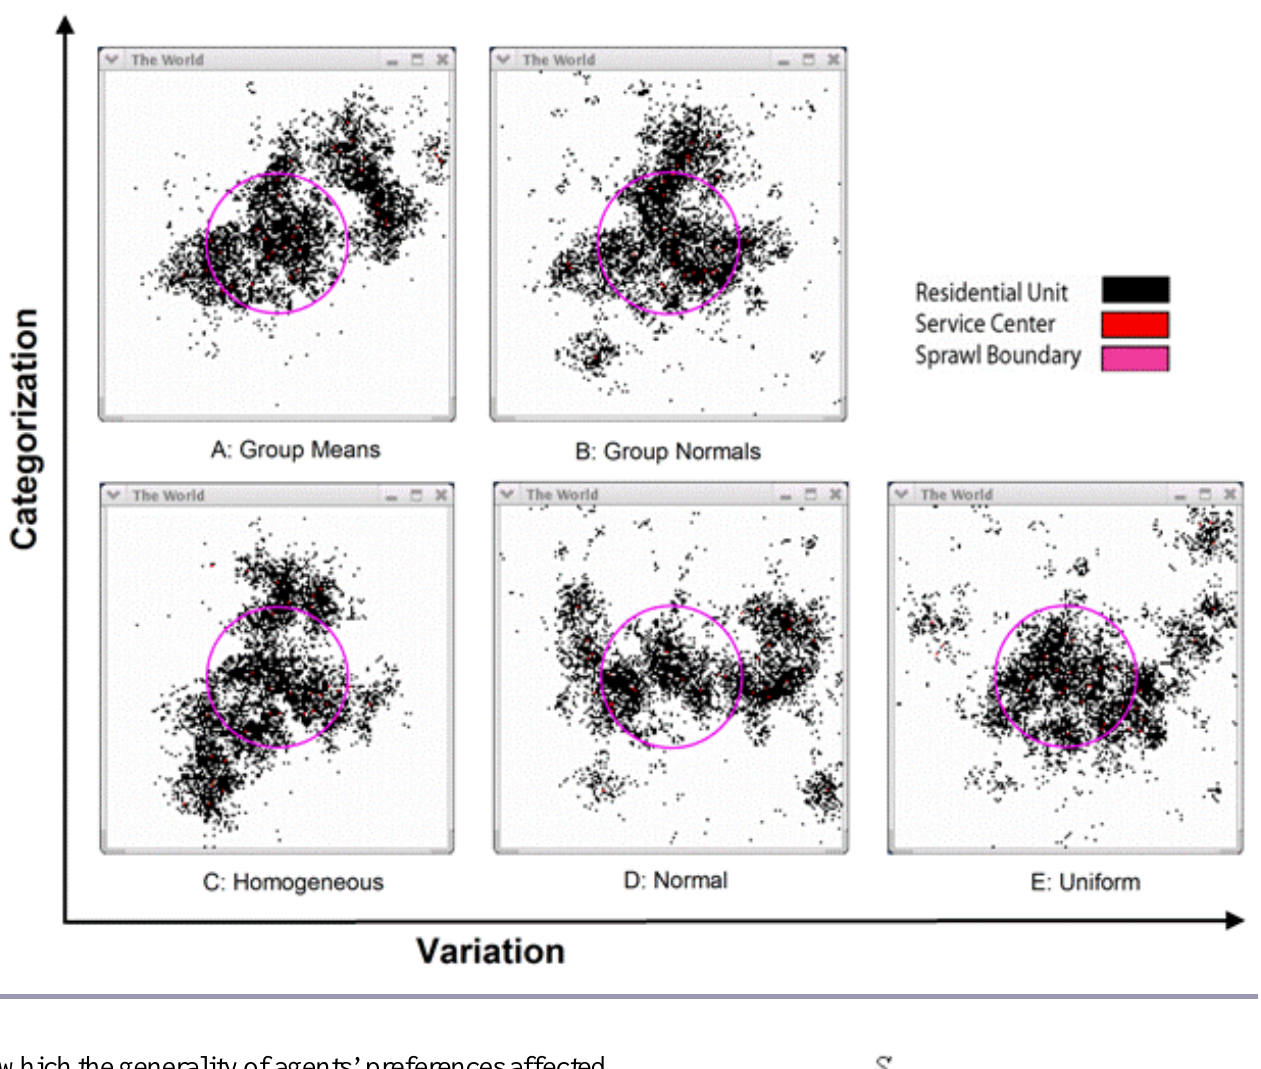
Fig. 4. Representative map results from a single run of the model under each of the experimental settings: A) Group Means, B) Group Normals, C) Homogenous, D) Normal, and E)